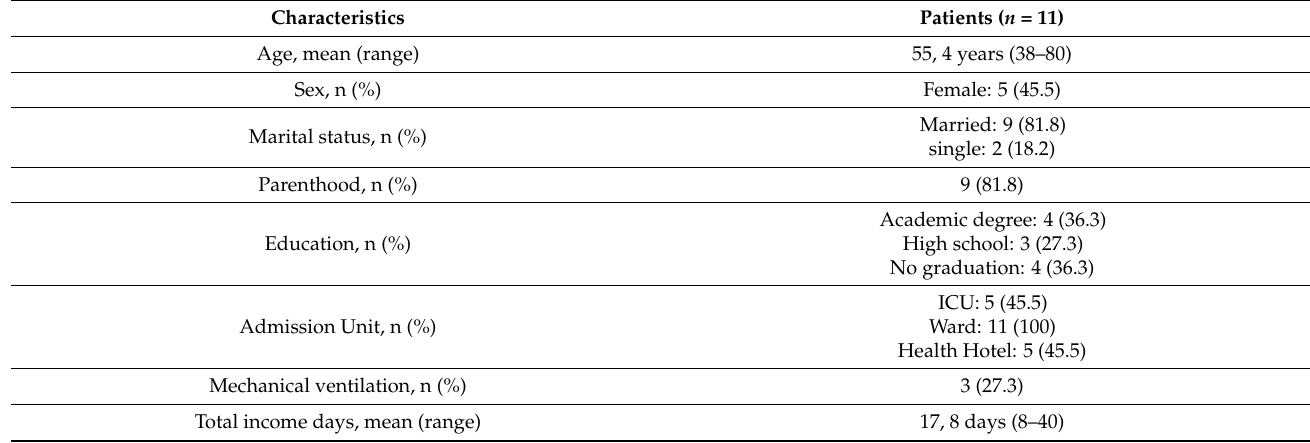
Table A2. Patient sample.